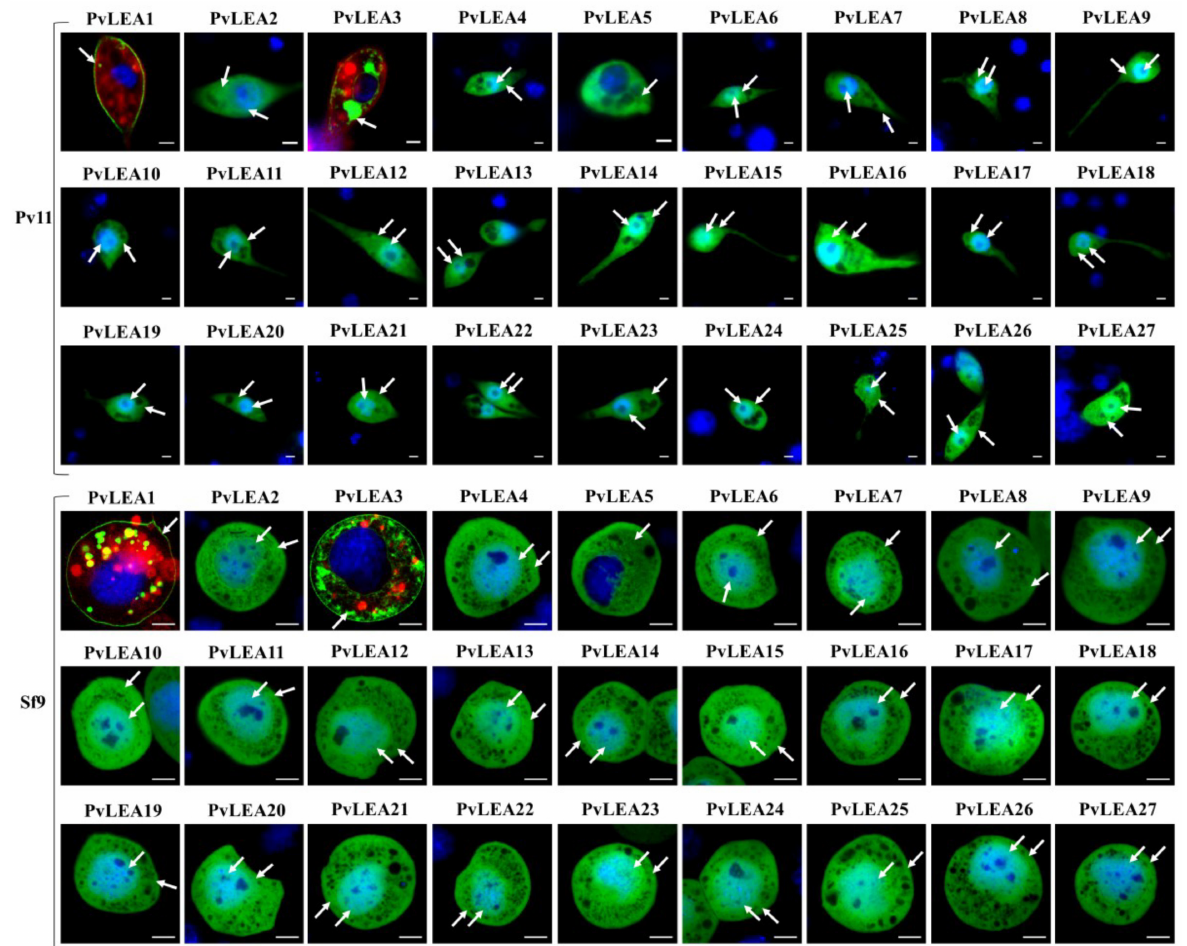
Figure 3. Representative images of PvLEA proteins’ localization in Pv11 and Sf9 cells. (Pv11) Local- ization of PvLEA(x)–AcGFP1 chimeras in Pv11 cells: endoplasmic reticulum (ER) or Golgi apparatus (PvLEA22), membrane (PvLEA1), cytosol and nucleus (PvLEA4) and cytosol only (PvLEA5). (Sf9) Localization of PvLEA(x)–AcGFP1 chimeras in Sf9 cells: cytosol and nucleus (PvLEA8) and cytosol only (PvLEA6). PvLEA proteins are indicated above image panels, respective organelles are indicated by arrows. The scale bar is 2 µ m for Pv11 cells and 5 µ m for Sf9 cells. ER/Golgi localization in Pv11 cells was verified using ER/Golgi staining (see Methods, Section 2.4). Pv11 cells membranes and DNA in both cell cultures were stained with CellVue Claret Far Red (red) and Hoechst 33,258 (blue), respectively. Green color represents emission of a green fluorescent protein (AcGFP1) expressed in fusion with PvLEA protein. The following filters were used: excitation at 405 nm, emission at 410–508 nm (blue channel); excitation at 488 nm, emission at 490–633 nm (green channel); excitation at 633 nm, emission at 638–759 nm (red